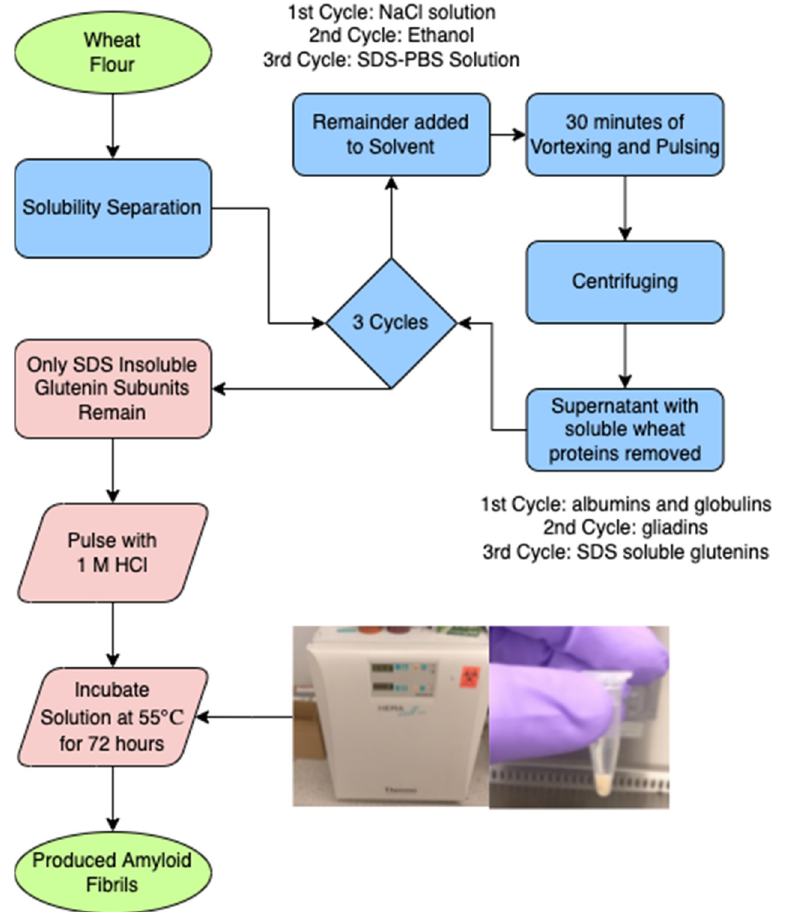
Figure 1. Simple flowchart of an overview of the amyloid synthesis